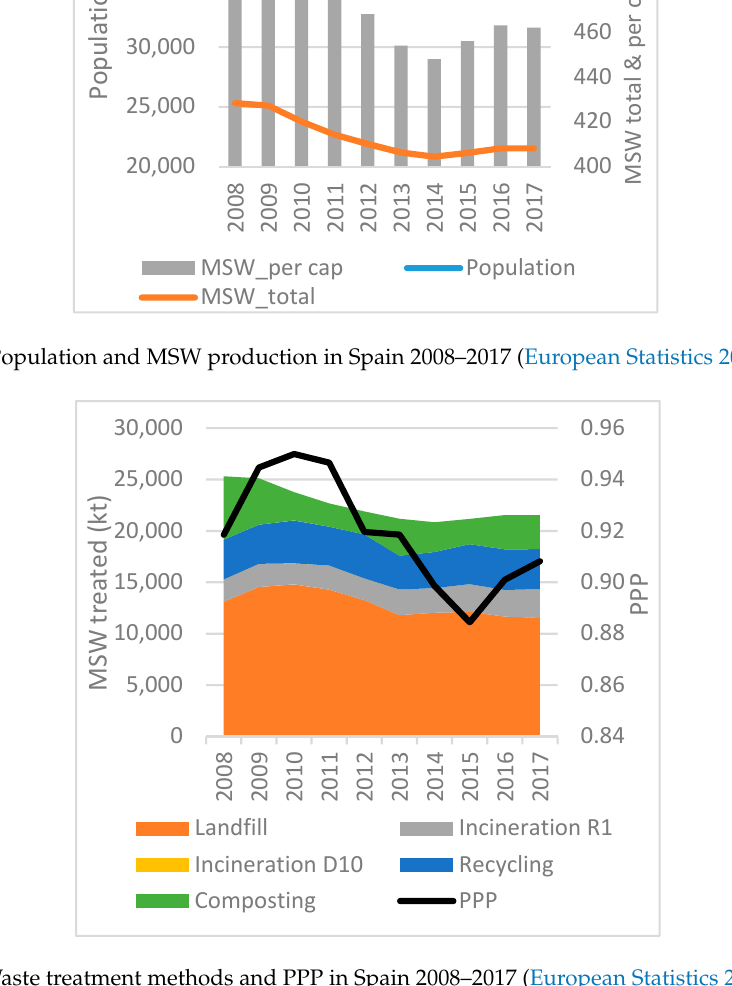
Figure 19. Population and MSW production in France 2008–2017 (EUROSTAT 2019a, 2019c).